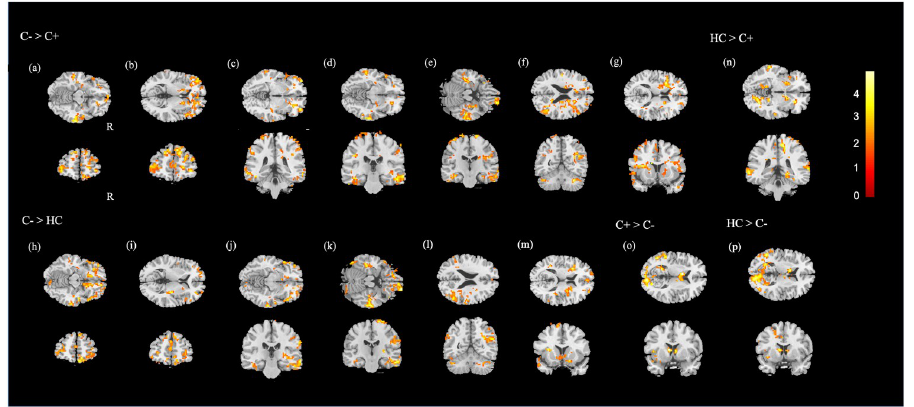
Fig 2. Post-hoc t test results. Compared with C+ group, hyperactivity on the (a, b) prefrontal cortex, (c, d) bilateral middle temporal gyrus, (e) right inferior temporal gyrus, (f) right angular gyrus and (g) left insula occurred in the C- group. Hypoactivity in HC group revealed in (h, i) prefrontal cortex, (j) right middle and (k) inferior temporal gyrus, (l) angular gyrus and (m) left insula in comparison between C- group as well. In all the post-hoc results (n) left middle temporal gyrus displayed hyperactivity in HC group than C+ group. Hypoactivity of the (o, p) left caudate in the C- group was revealed in comparison with the C+ and HC group (cluster size > 50, corrected p < 0.05, color bar, t